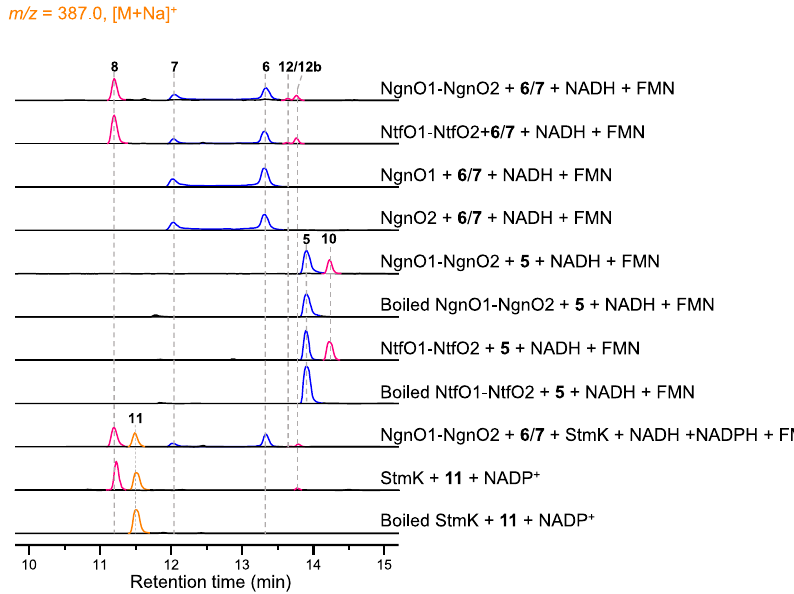
Fig. 3 LC-MS analysis of NgnO1-NgnO2, StmK, and NtfO1 – NtfO2 catalyzed reaction. NgnO1-NgnO2 catalyzes a hydroxylation step on 6/7 or 5 when incubated with FMN and NADH; NgnO1 or NgnO2 alone has no effects on 6/7; NtfO1-NtfO2 has the same function with NgnO1-NgnO2; StmK catalyzes a ketoreduction step on the putative intermediate 12b ; StmK can catalyze a reverse reaction using 11 as substrate and NADP + as a